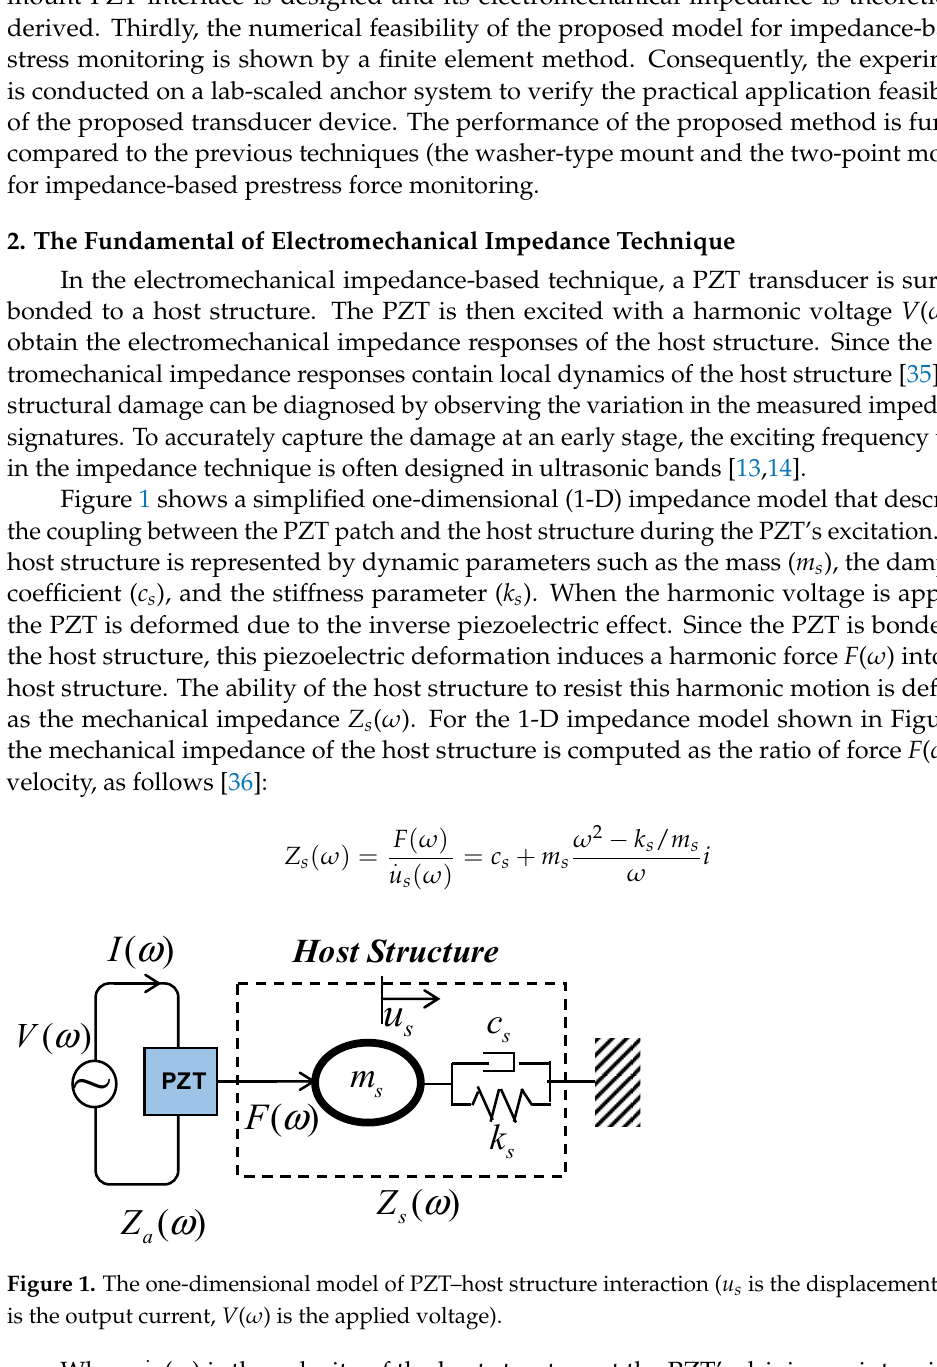
angular frequency of the excitation voltage; i is the imaginary